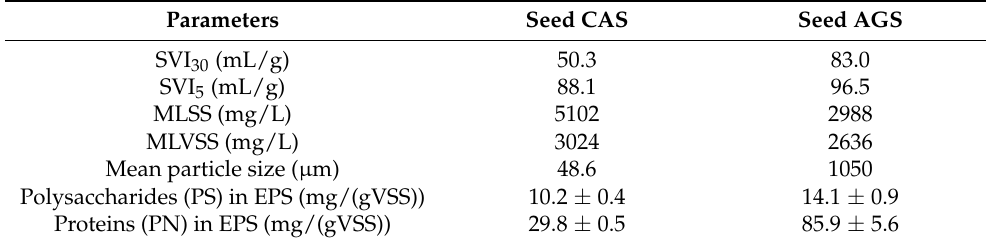
Table 1. Characteristics of seed conventional activated sludge (CAS) and seed aerobic granular sludge